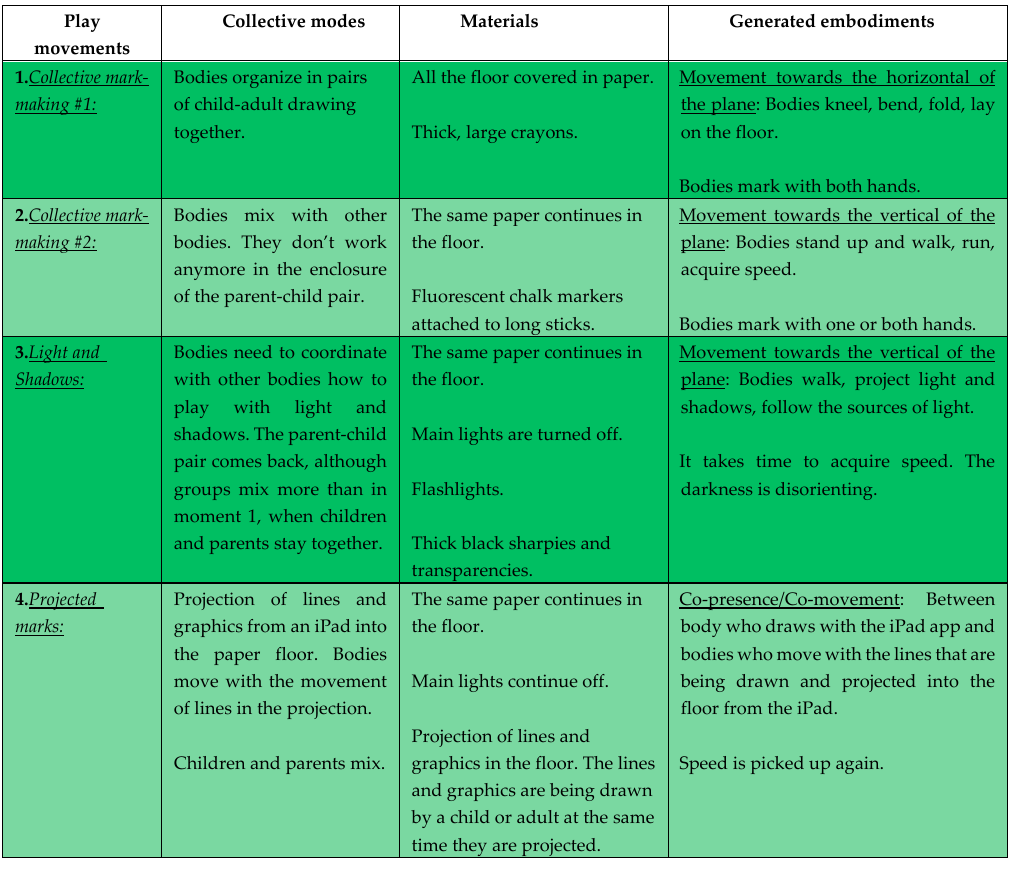
Figure 1. Moving with lines and light: co-alignments of play movements, their collective modes, the materials present in each movement, and the generated embodiments.